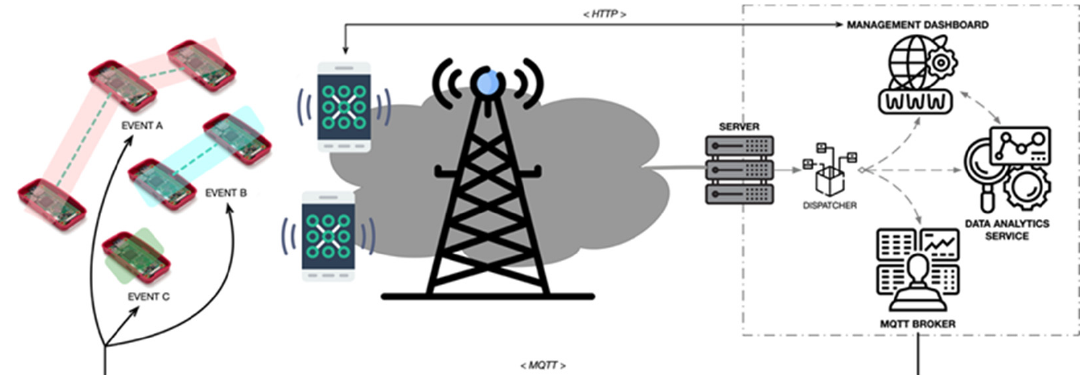
Figure 2. System overview.